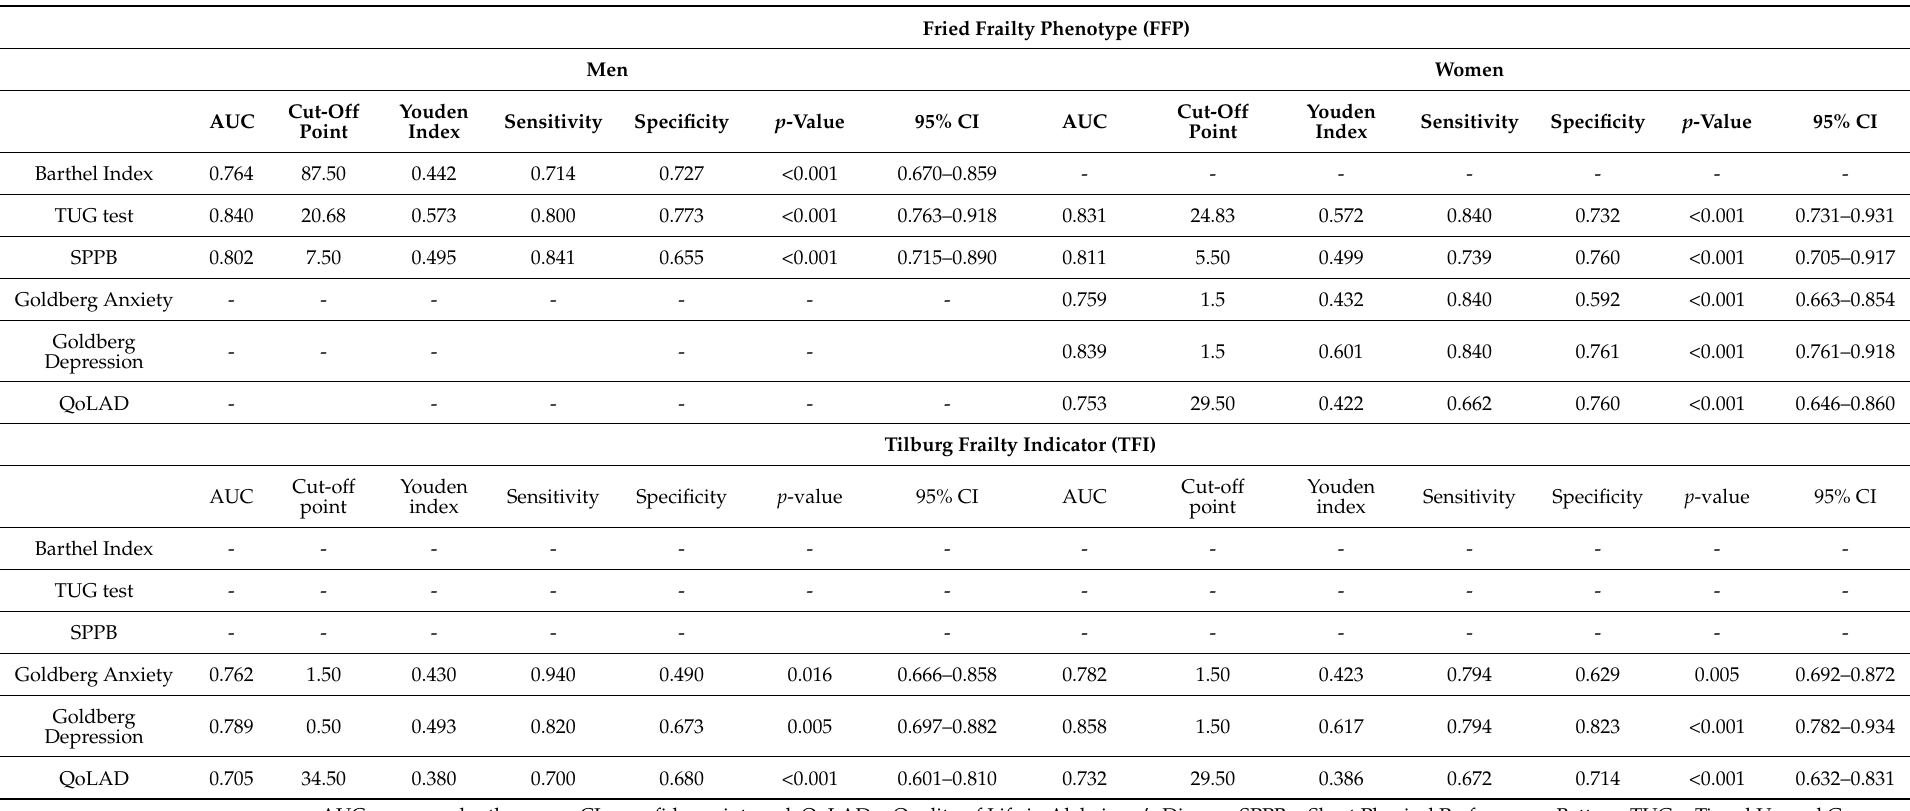
Table 3. Sex differences in frailty according to receiver operating characteristic